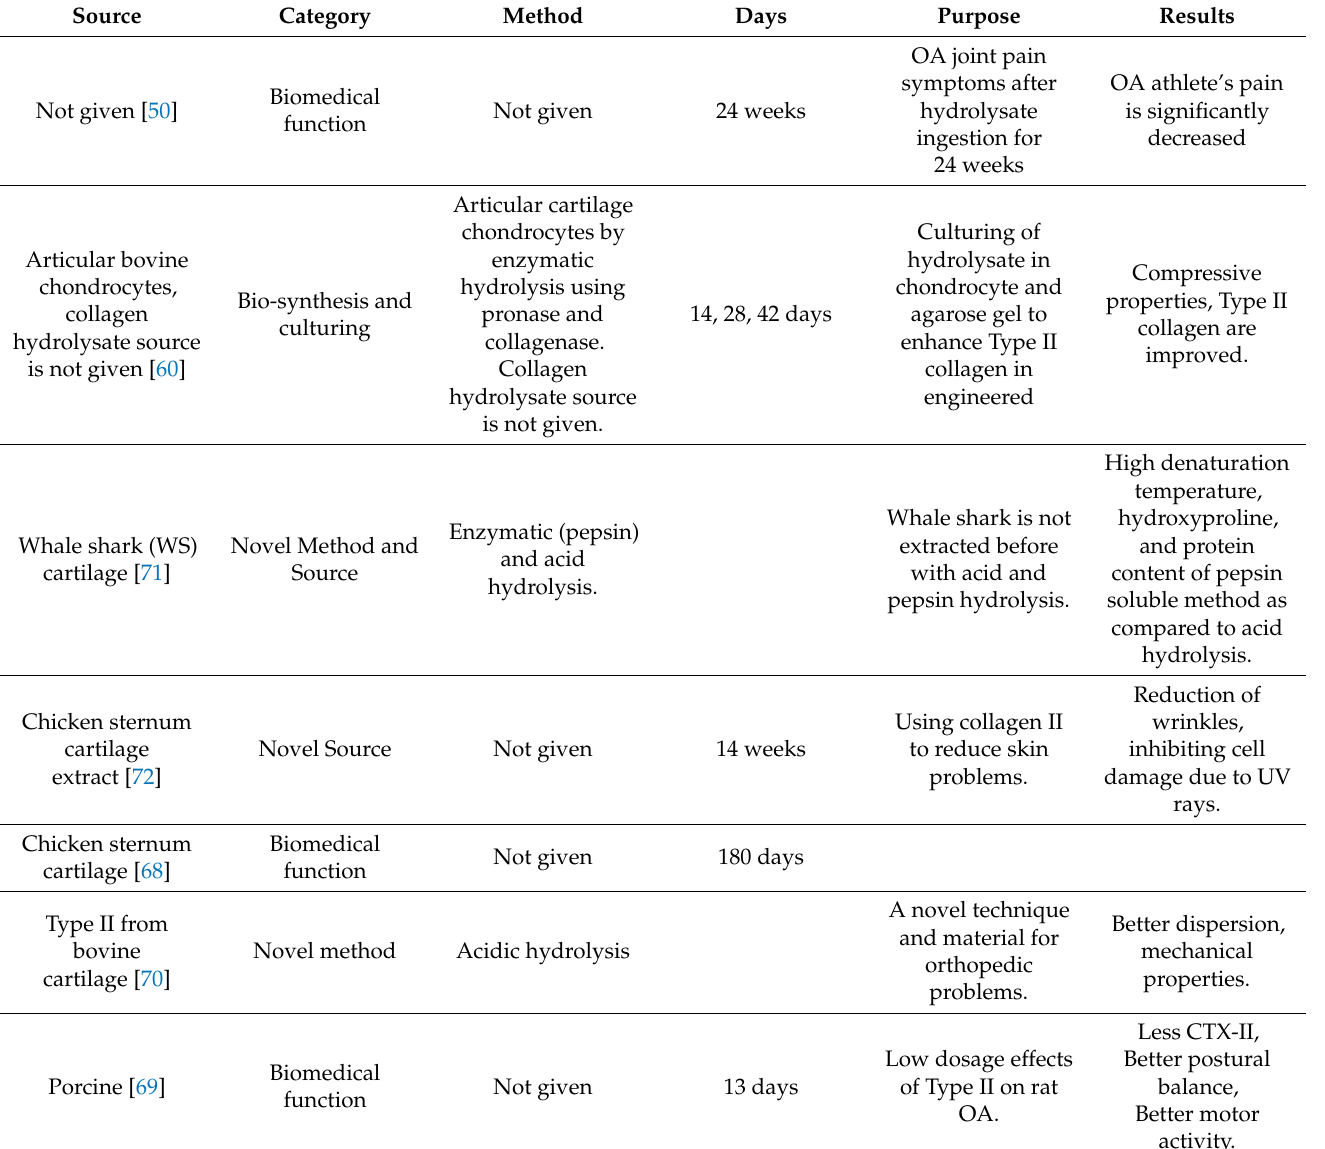
Table 3. Examples for Type II collagen or collagen